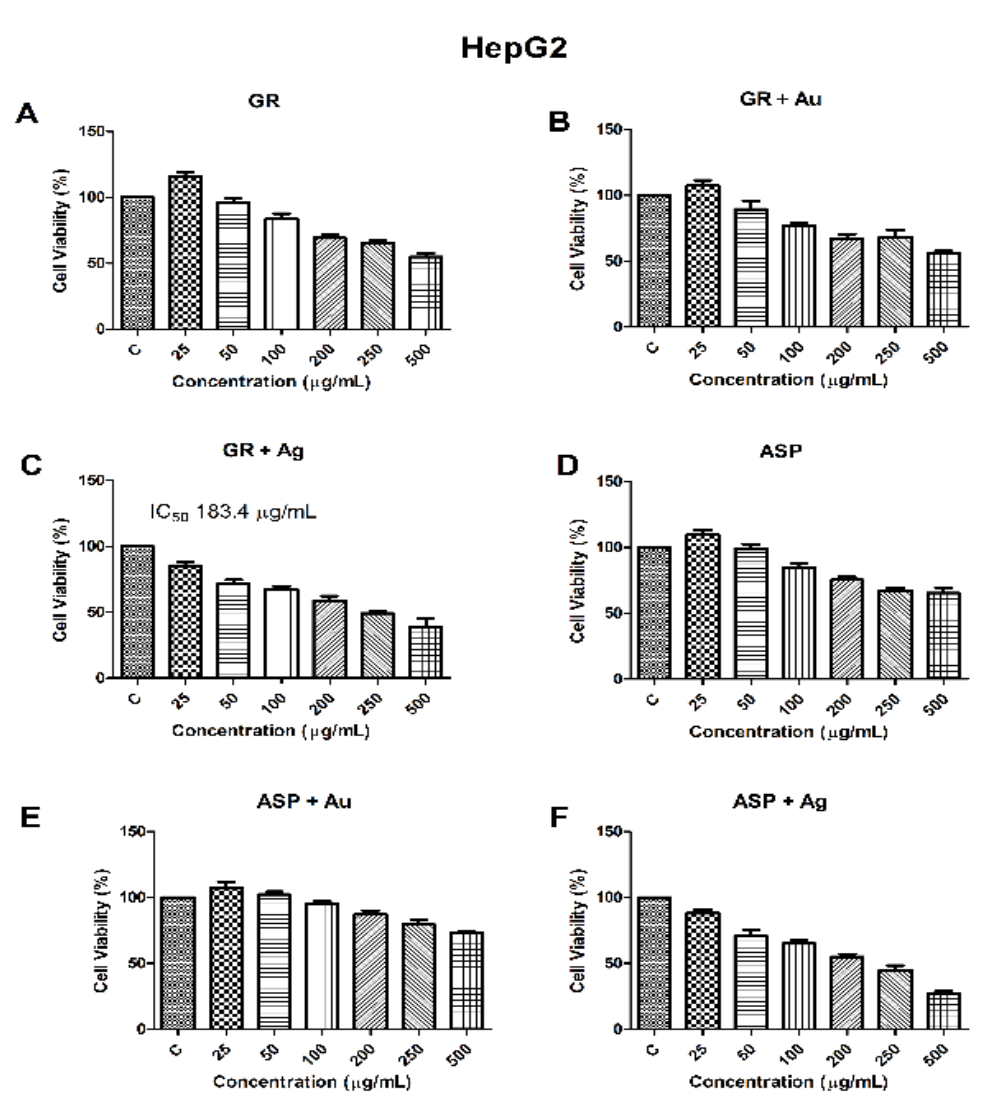
Figure 8. The results of the MTT assay in HepG2 treated with GR total extract ( A ), GR-AuNPs ( B ), GR-AgNPs ( C ), ASP ( D ), ASP-AuNPs ( E ), ASP-AgNPs ( F ) after 24 h (results are reported as the viability in comparison with the control samples). Among the tested samples, the IC 50 concentration (Subgraph C ) was most cytotoxic at concentrations 50–100 μ g/mL.